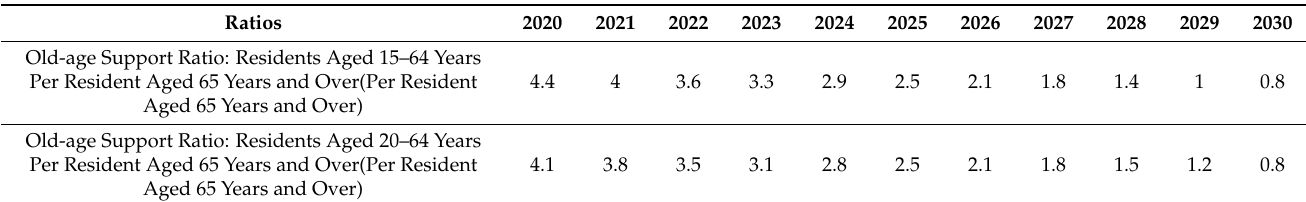
Table 6. Old-age support ratio: residents aged 15–64 and 20–64 years per resident aged 65 years and over (per resident aged 65 years and over).